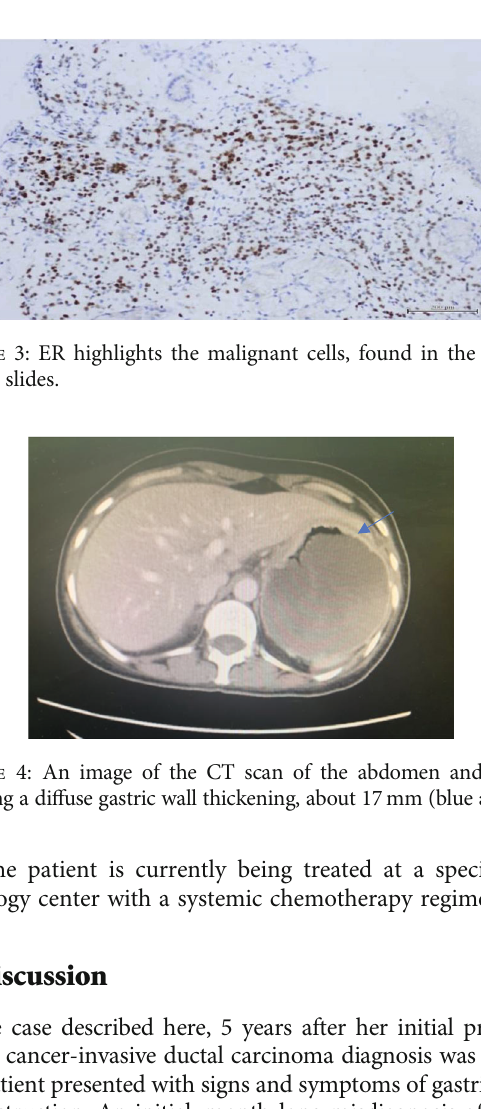
Figure 2: High power of the gastric biopsy with expanded lamina propria by malignant cells arranged in cords.